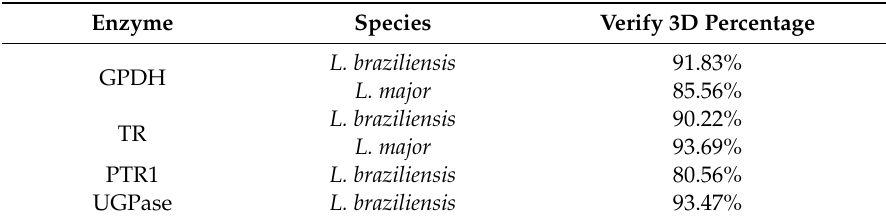
Table 5. Percentage of the degree of compatibility between the 3D structure and the 1D amino acid sequence, based on Verify 3D generated models.